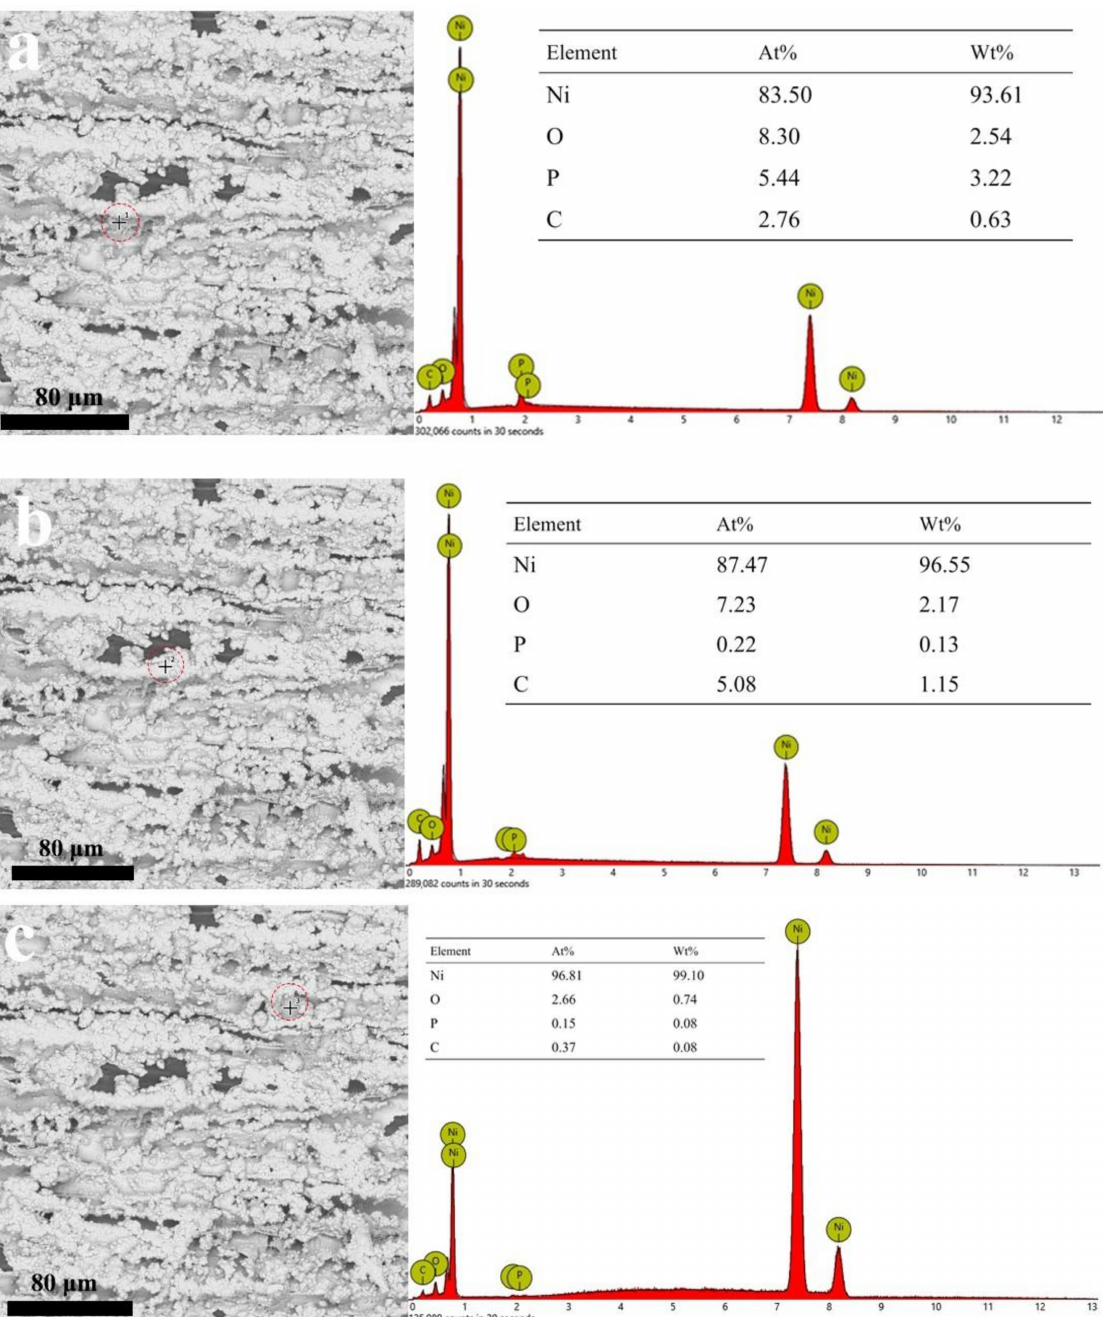
Figure 3. EDS spot scanning map of the first electroless Ni for 15 min and corresponding elemental mapping (( a ): point 1, ( b ): point 2, ( c ): point